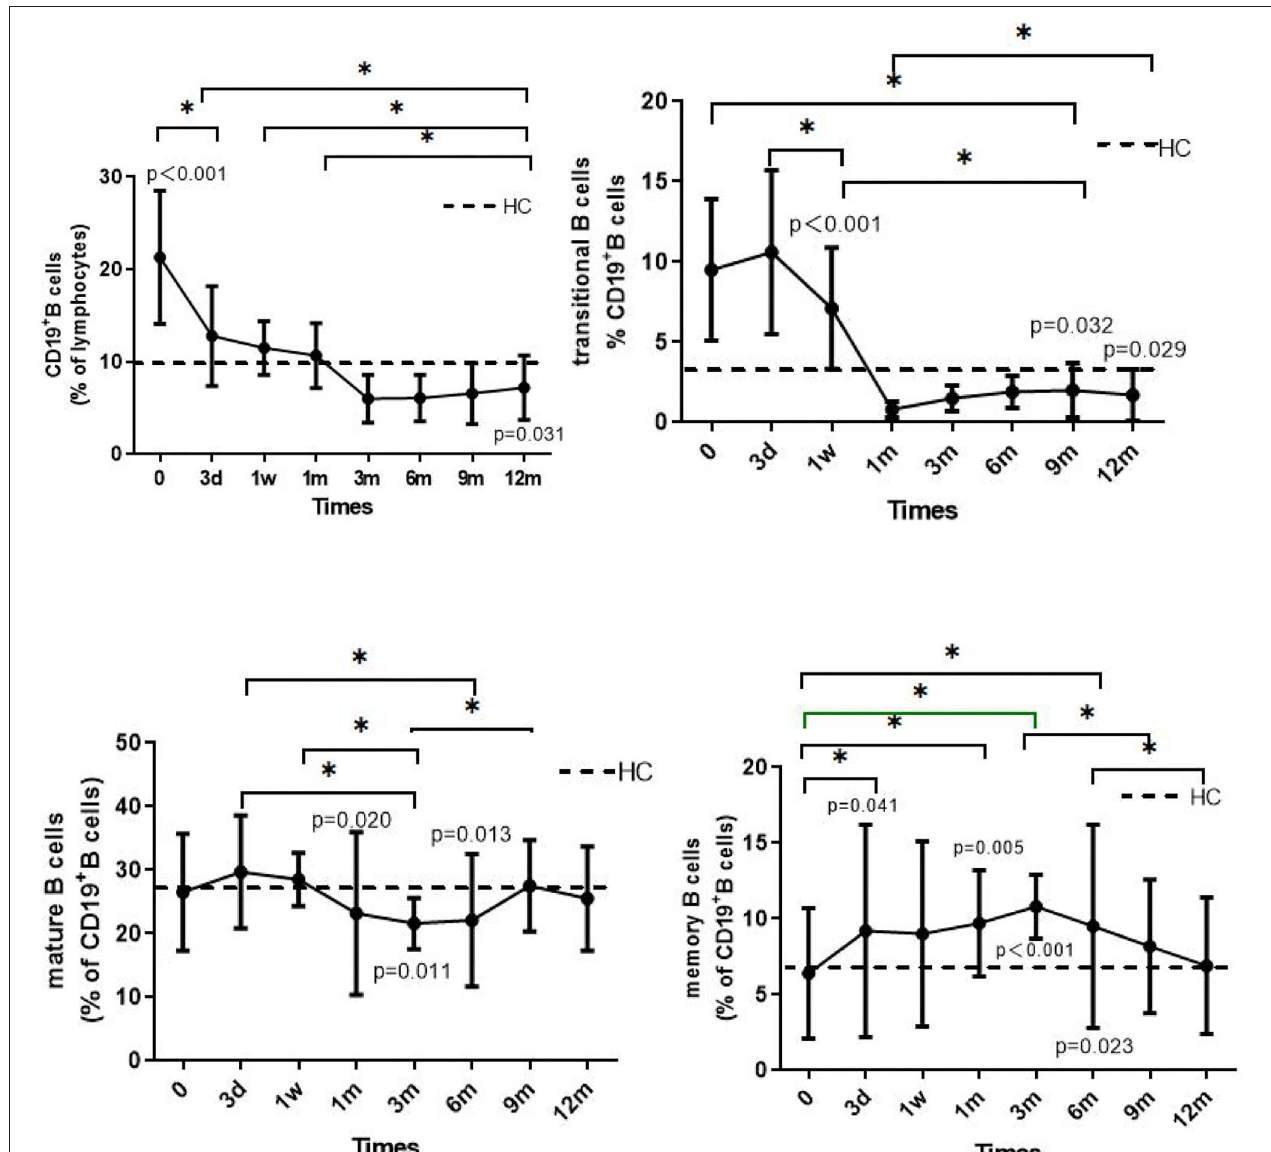
FIGURE 2 | The solid line shows the dynamic changes in total B cells, transitional B cells, mature B cells, and memory B cells in patients with INS. The dotted line shows the mean value of the HC group, measured only once. The p -value is for the comparison between the patients and the HC group at each time point. The asterisks (*) indicate a significant difference between the two time points ( p <